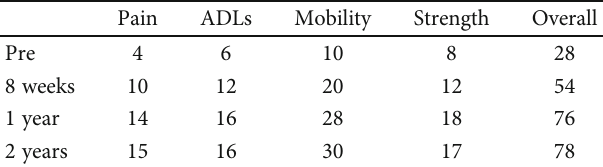
Table 1: Constant score of the patient (including its